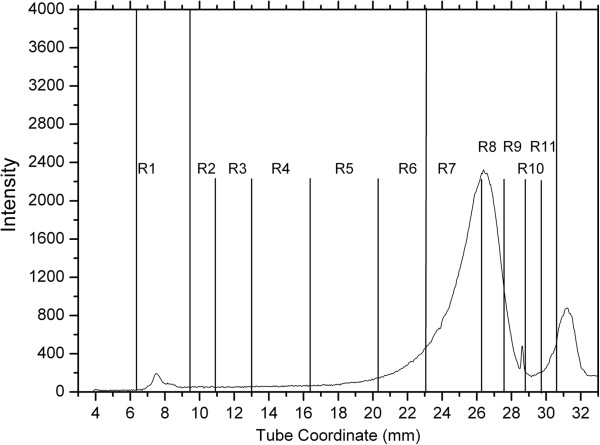
Representative continuous lipoprotein density profile from a dog of group 2A (normolipemic Miniature Schnauzers). Axes descriptions are provided in Figure 4 legend. This Miniature Schnauzer had serum TAG and cholesterol concentrations within the respective reference intervals. The CLPDP of these dogs were generally similar to those of group 1 (Figure 4) with regard to the abundance of major lipoprotein classes. However, most dogs in group 2A showed more abundant R1 and less abundant R2 – R6 fractions compared to group 1 dogs.